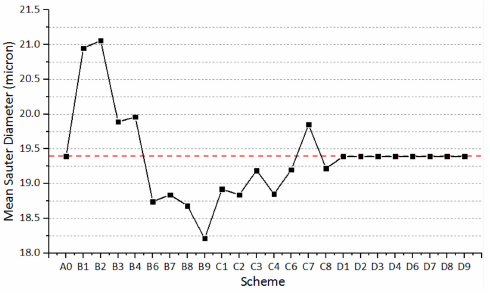
Figure 40. Time-averaged SMD for each optimized